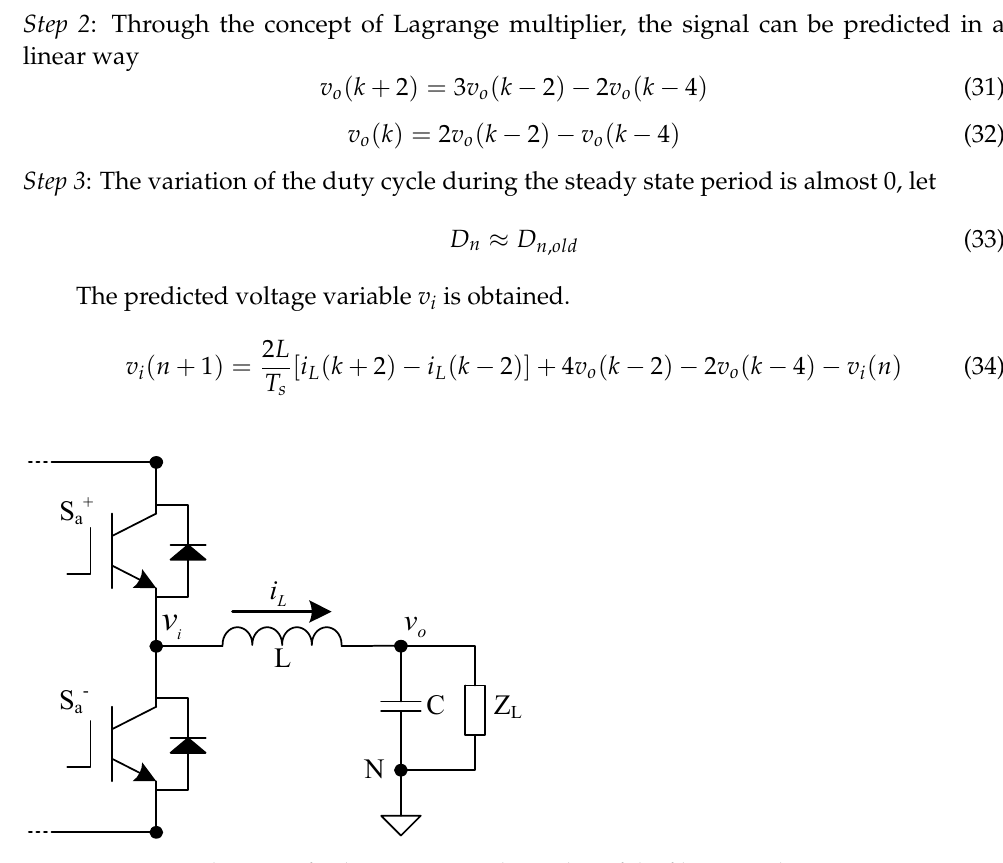
Figure 17. Circuit diagram of voltage–current relationship of the filtering inductor.